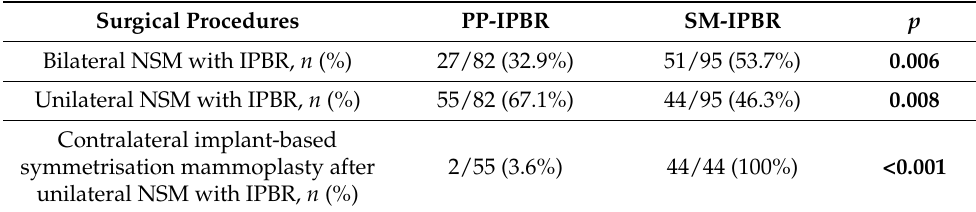
Table 3. Type of surgical treatment.